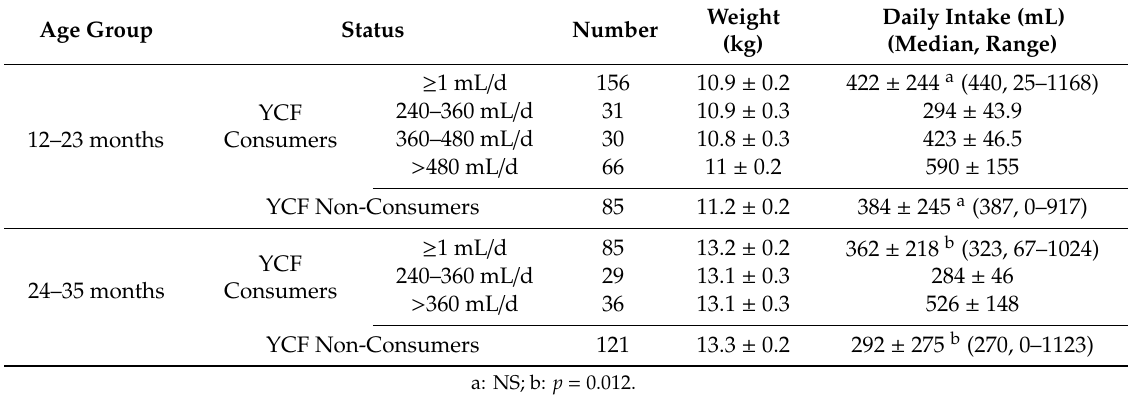
Table 2. Mean body weight and intake of YCF or cow’s milk ( ± SD) in each age group.